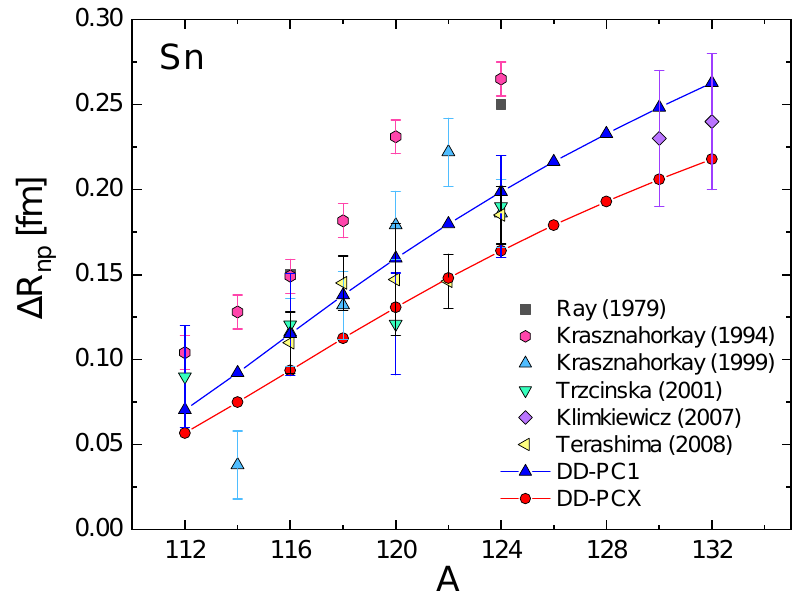
Figure 4. The neutron skin thickness for Sn isotopes as a function of the mass number. The experi- mental data are taken from References